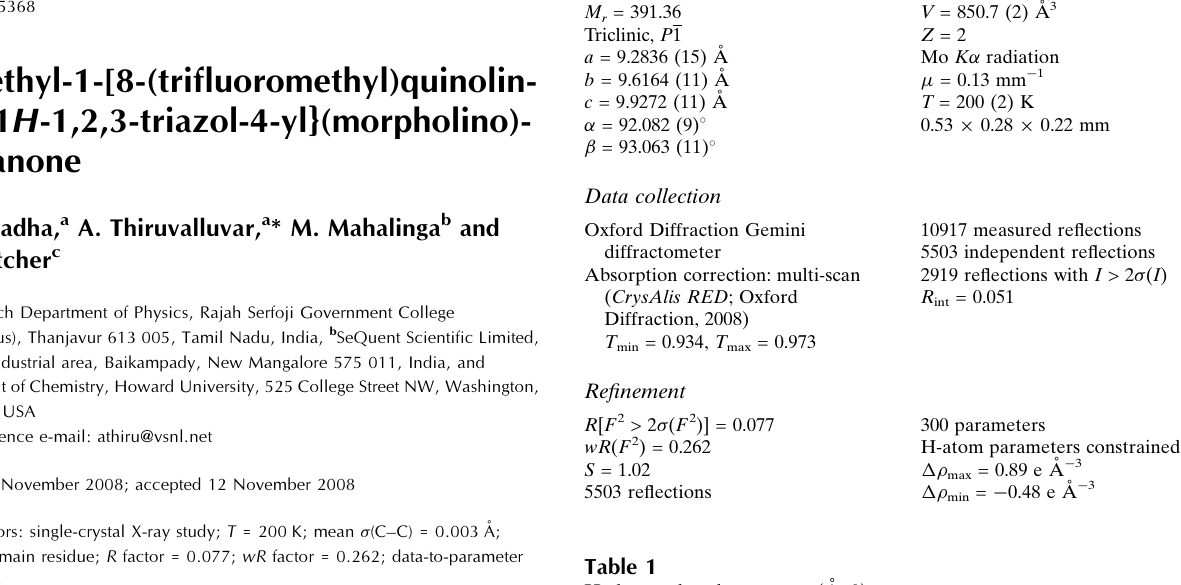
Hydrogen-bond geometry (A˚ , (cid:1) ).